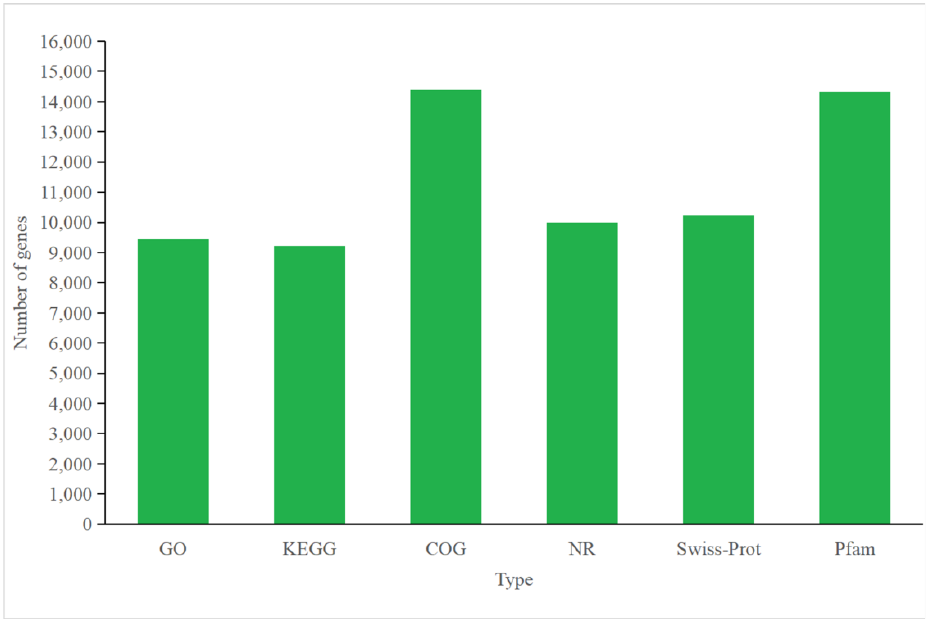
Figure 9. Functional annotation of unigenes in C. fusiformis